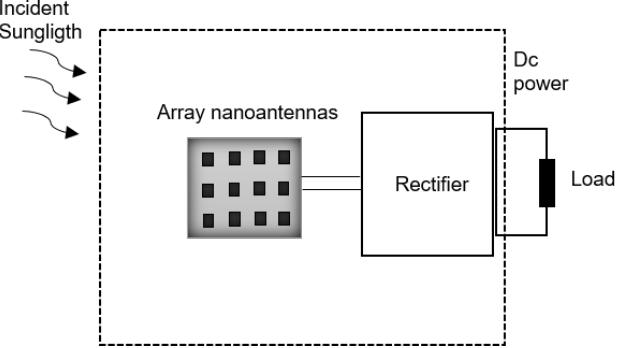
Figure 1. Representation of the nano-rectenna system (adapted from the work in